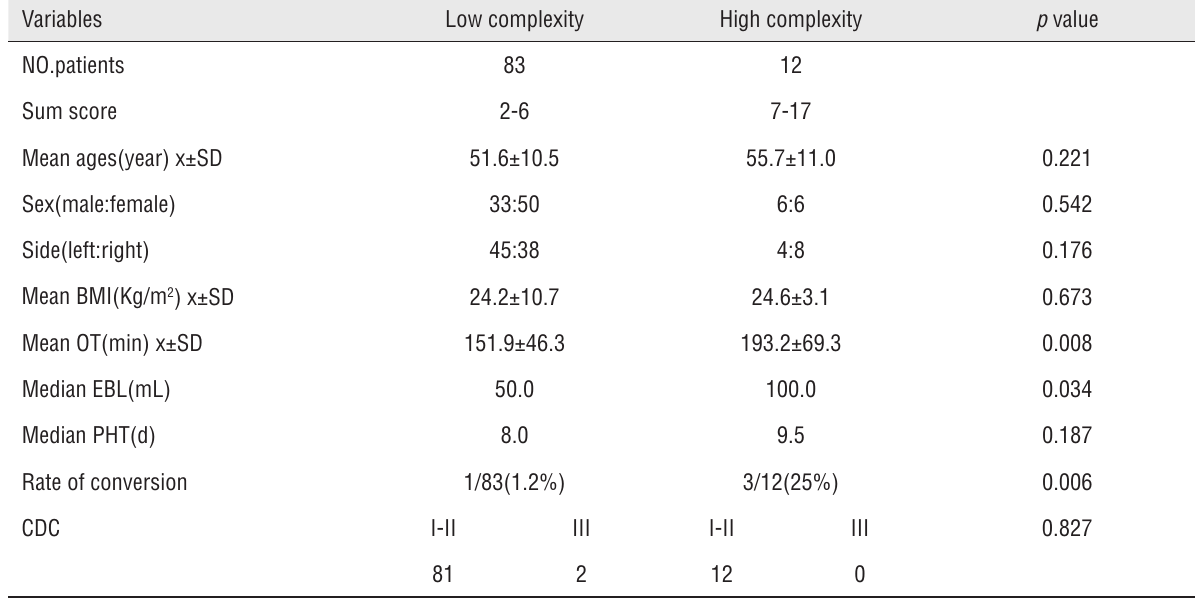
Table 2 - Patients baseline characteristics and peri-operative variables.